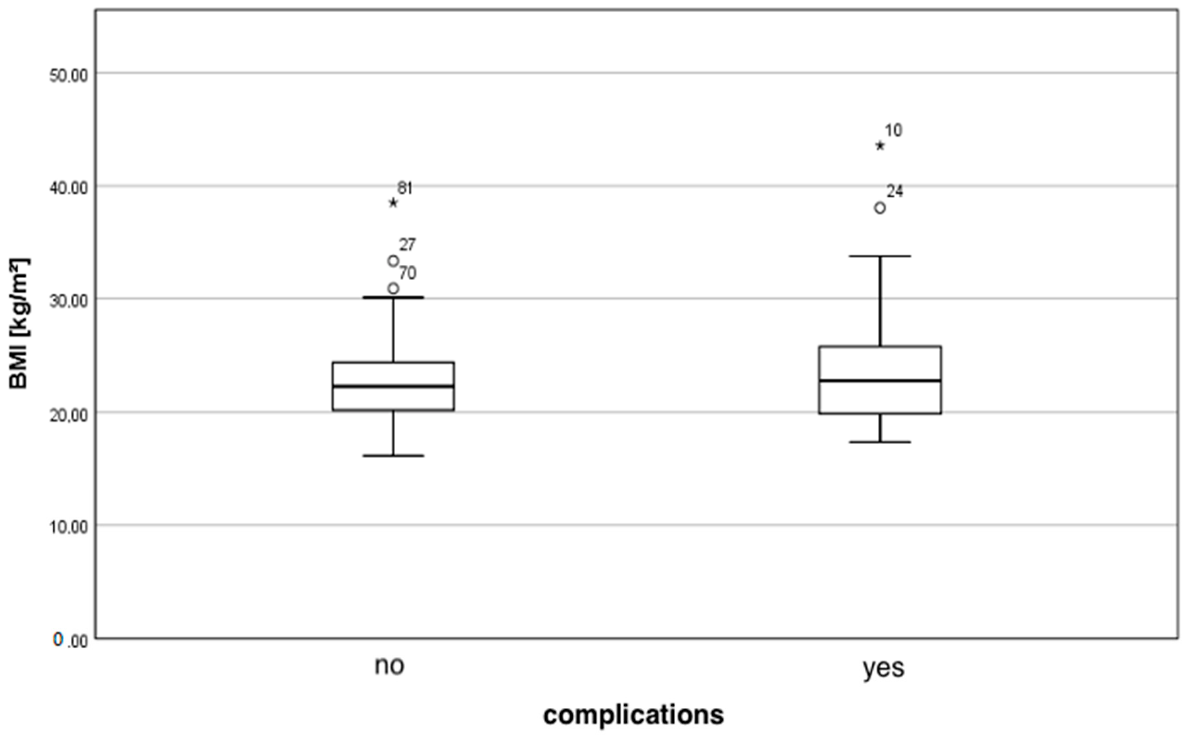
Figure 1. Distribution of the BMI depending on